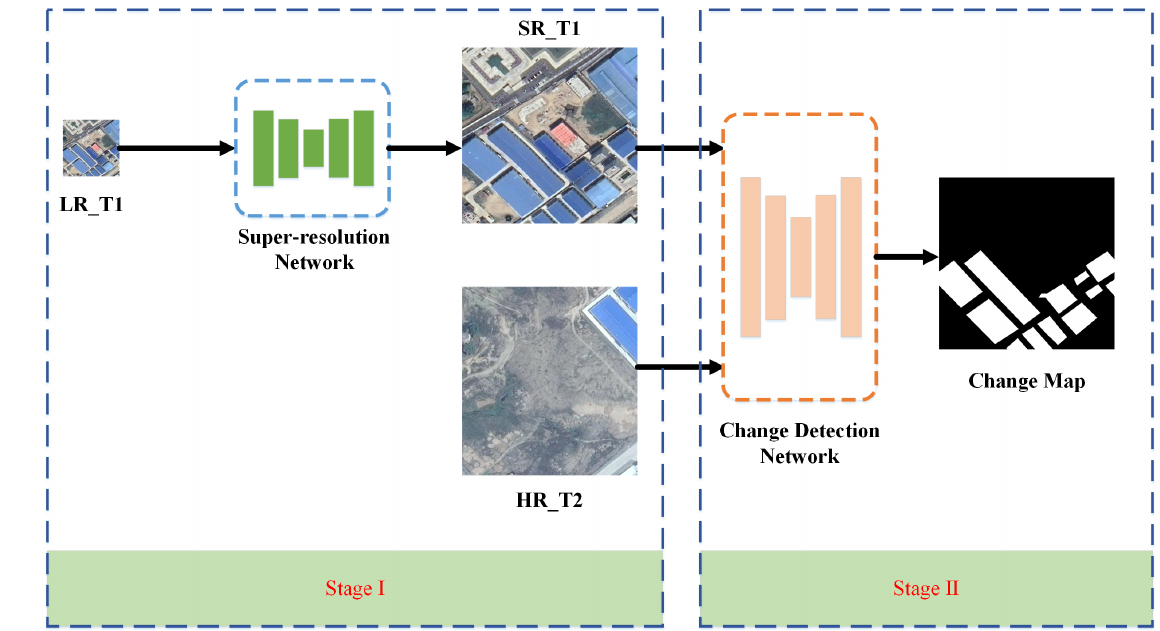
Figure 1. Overview of the proposed